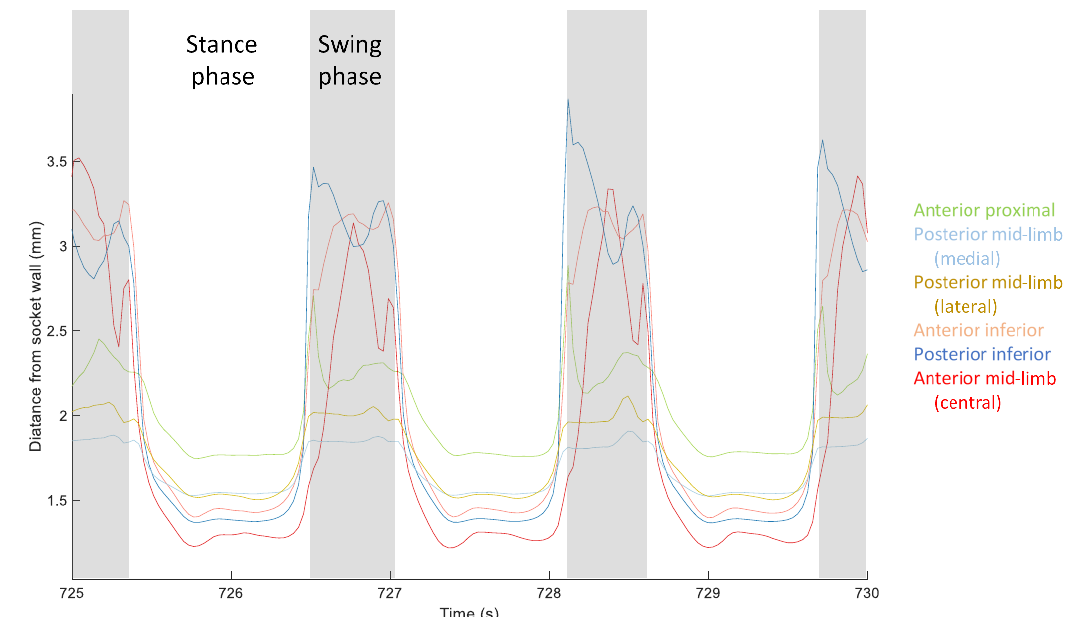
Figure 7. Exemplary data from a participant with trans-tibial amputation. Data from three steps are shown. Stance phase is unshaded, and swing phase is shaded gray.